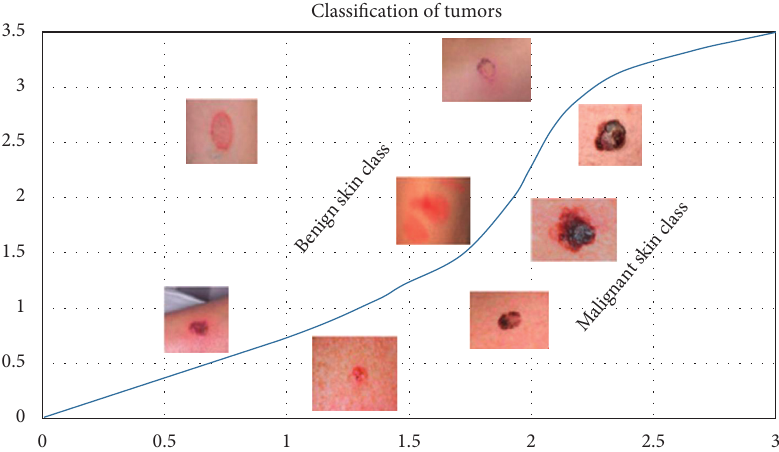
Figure 9: Distribution of tumor skin image over classifier into two classes.